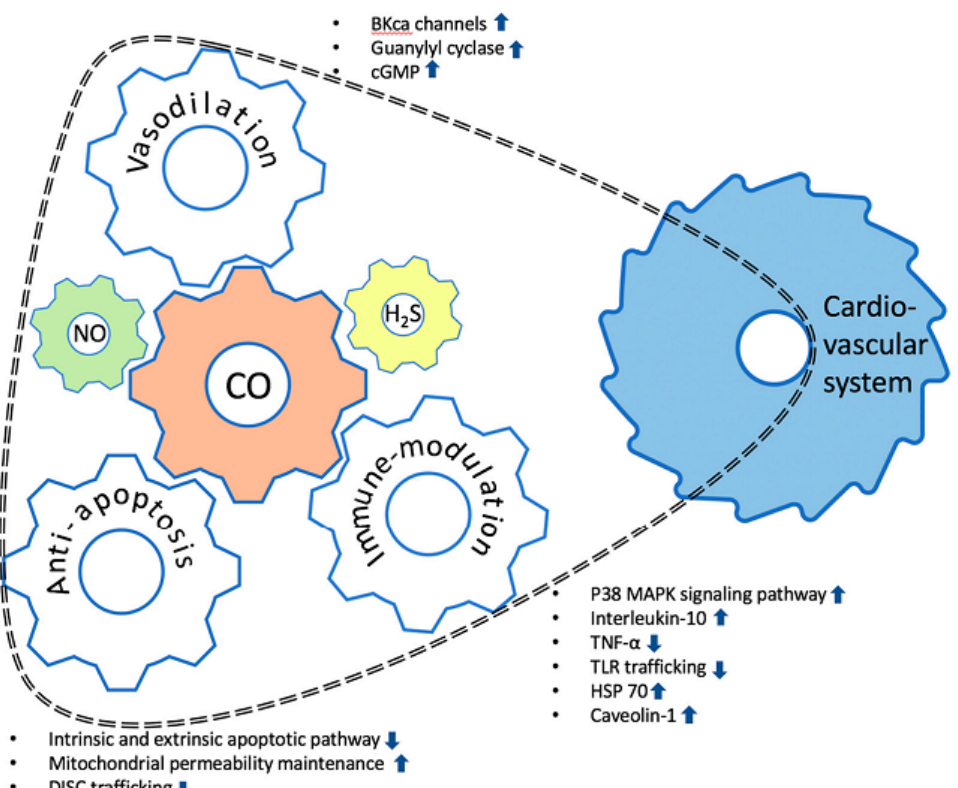
Figure 1. Schematic diagram of the effects of carbon monoxide on the cardiovascular system. Carbon monoxide (CO) can influence the cardiovascular system through (1) the vasodilatory effect, (2) anti-apoptotic activity, and (3) immune-modulation mechanisms. The roles of CO in the cardiovascular system may be executed in conjunction with other gasotransmitters, such as nitric oxide (NO) and hydrogen sulfide (H 2 S). The possibility of action on the cardiovascular system is represented by the dotted line. The upward pointing arrow and the downward pointing arrow mean activation and inhibition for each pathway,